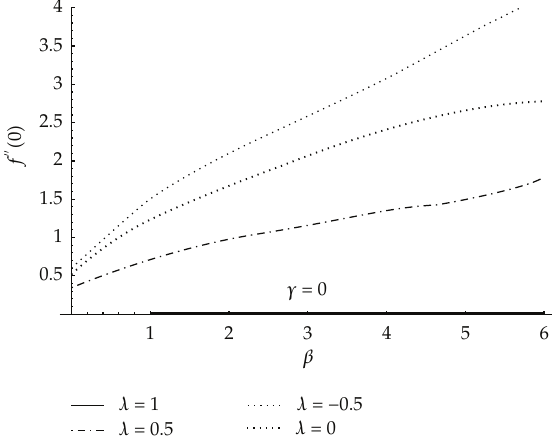
Figure 7: Shear stress f (cid:5)(cid:5) (cid:5) 0 (cid:6) versus the stretching parameter β for various values λ (cid:8) 1 , 0 . 5 , 0 and − 0 .